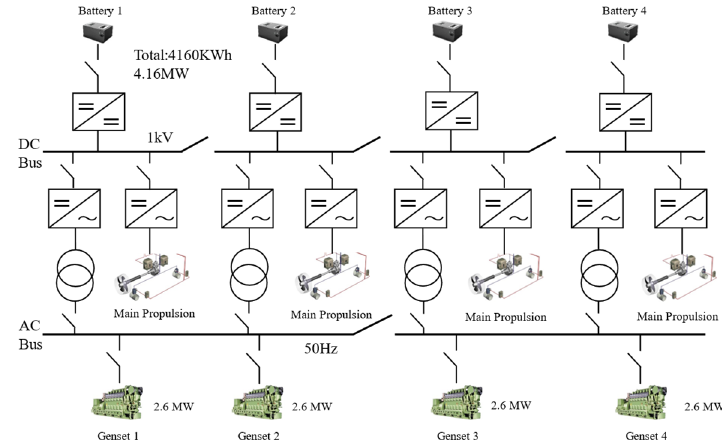
Figure 1. Power grid Structure diagram of a ferry.